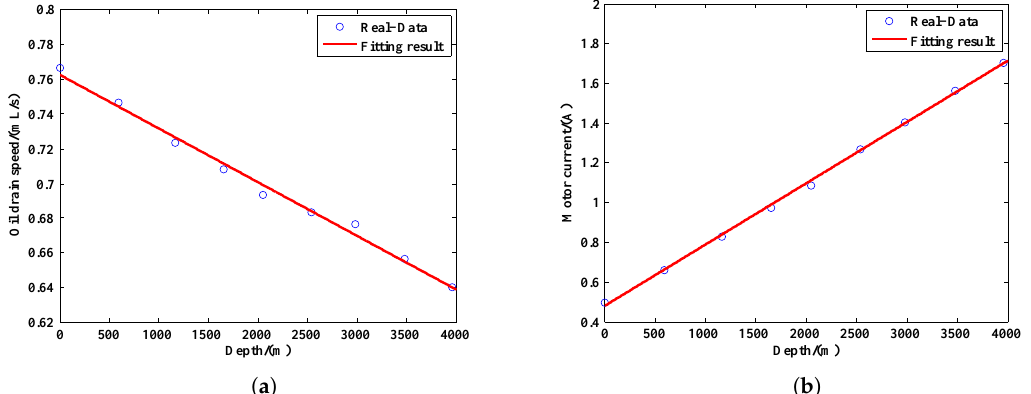
Figure 12. The fitting effect of the oil draining speed and motor’s operating